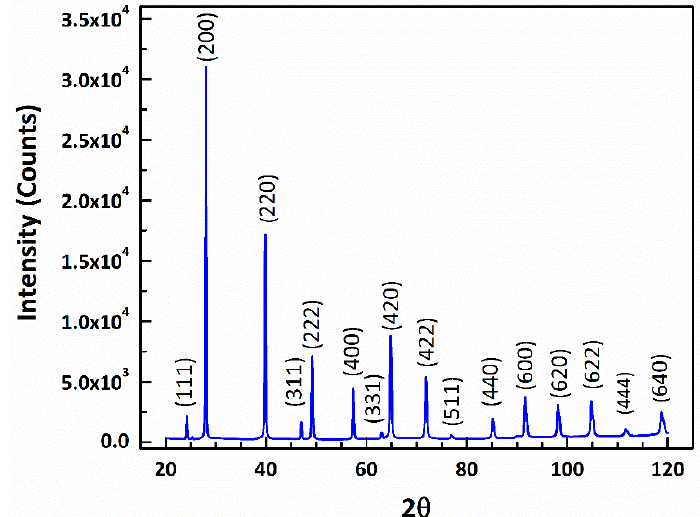
Figure 1. A fully-indexed powder x-ray diffraction (XRD) pattern acquired from the hot-pressed (HP) as-pressed, (PbTe) 0.97 (Ag 2 Te) 0.03 series, corresponding with the rock-salt PbTe crystal structure (JCPDS number 04-002-0317).